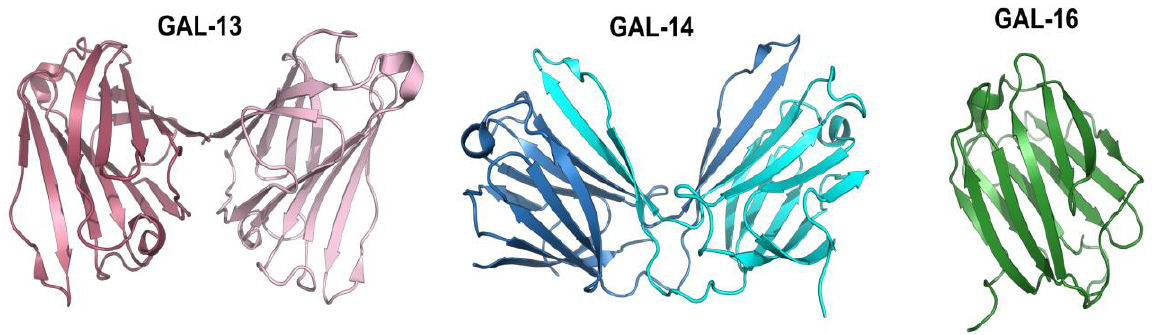
Figure 1. Three-dimensional structures of placental galectins. The dimeric structures of human GAL-13 and GAL-14 are shown respectively in purple/pink (GeneID UniProt Q9UHV8) and blue/cyan (GeneID UniProt Q8TCE9). GAL-13 is a prototype member stabilized by forming two disulfide bridges at the dimer interface [29]. In contrast, GAL-14 adopts a swapped dimer architecture, whereby terminal β -strands S5 and S6 of one monomer interact with the core structure of the opposite monomer (and vice versa) to form the canonical CRD ‘jelly-roll’ fold [30]. GAL-16 is shown in green (GeneID UniProt A8MUM7). Although prototype galectins typically crystallize as dimers, GAL-16 adopts a distinct monomeric structure [21].